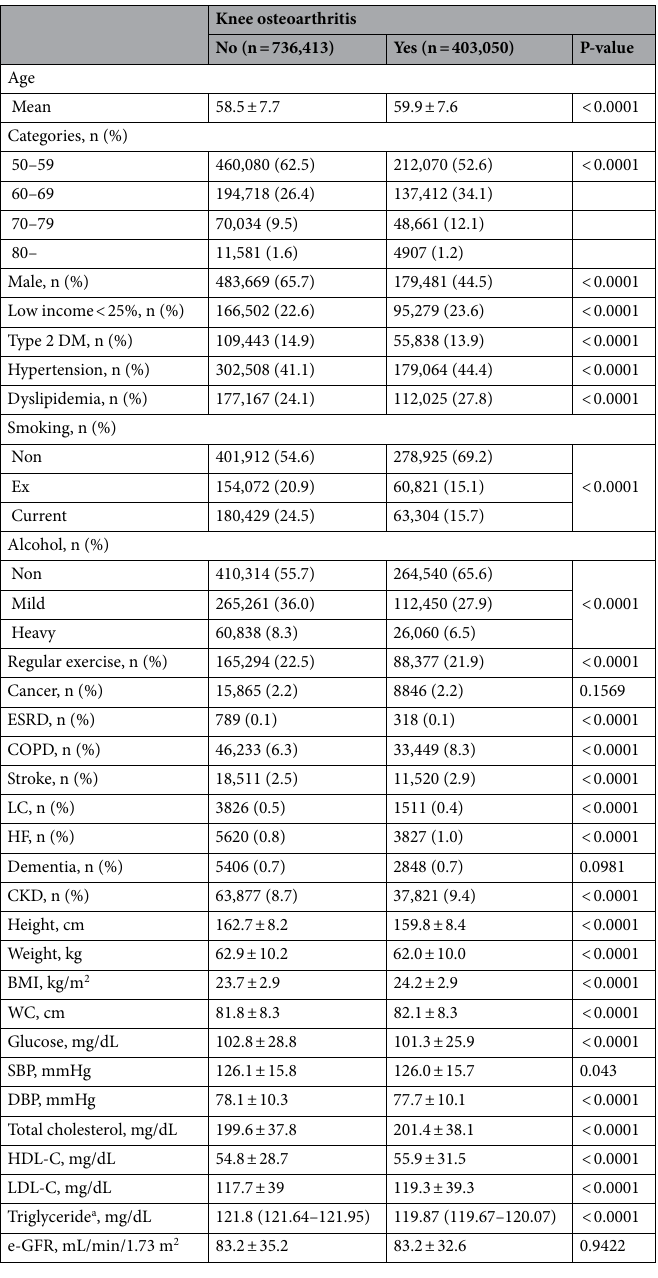
Table 1. Baseline characteristics of study participants according to knee OA development. Continuous variables were presented using mean and standard deviation. Categorical variables are expressed in numbers and percentages. DM diabetes mellitus, ESRD end-stage renal disease, COPD chronic obstructive pulmonary disease, LC liver cirrhosis, HF hear failure, CKD chronic kidney disease, BMI body mass index, WC waist circumference, SBP systolic blood pressure, DBP diastolic blood pressure, HDL high-density lipoprotein cholesterol, LDL-C low-density lipoprotein cholesterol, e-GFR estimated glomerular filtration rate. a Geometric mean values for